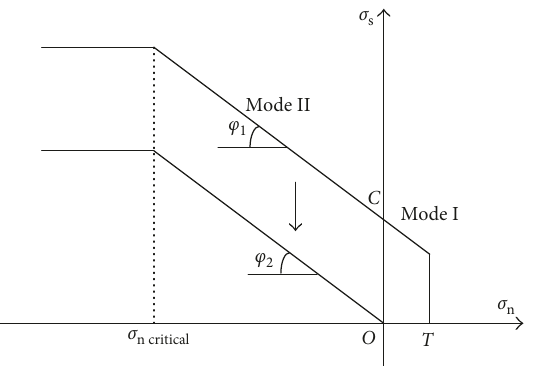
Figure 5: Failure criterion of interfaces.